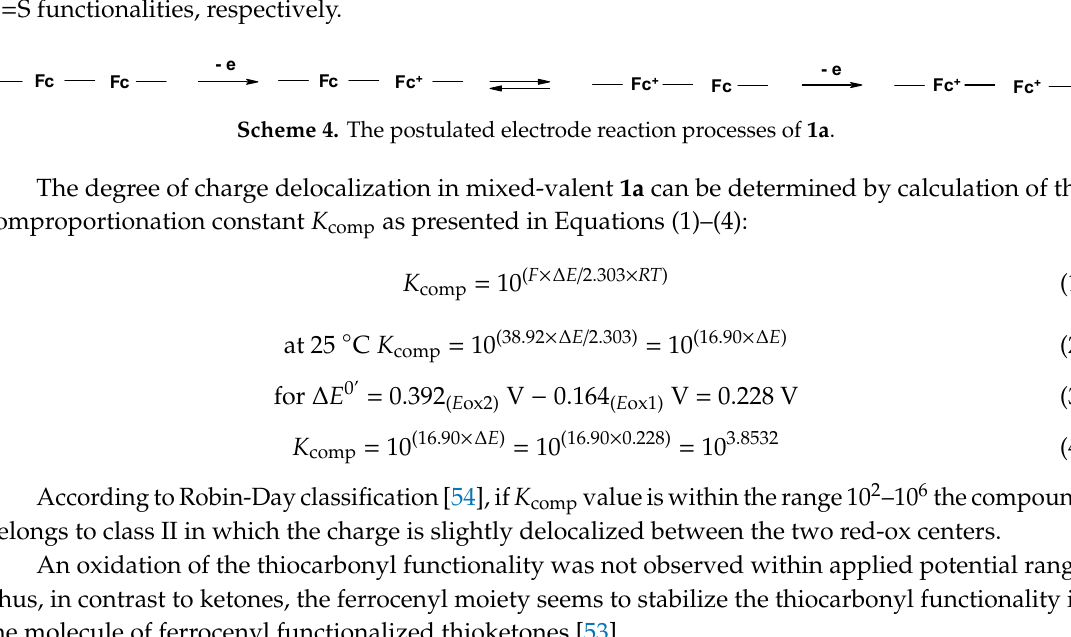
Scheme 4. The postulated electrode reaction processes of 1a .